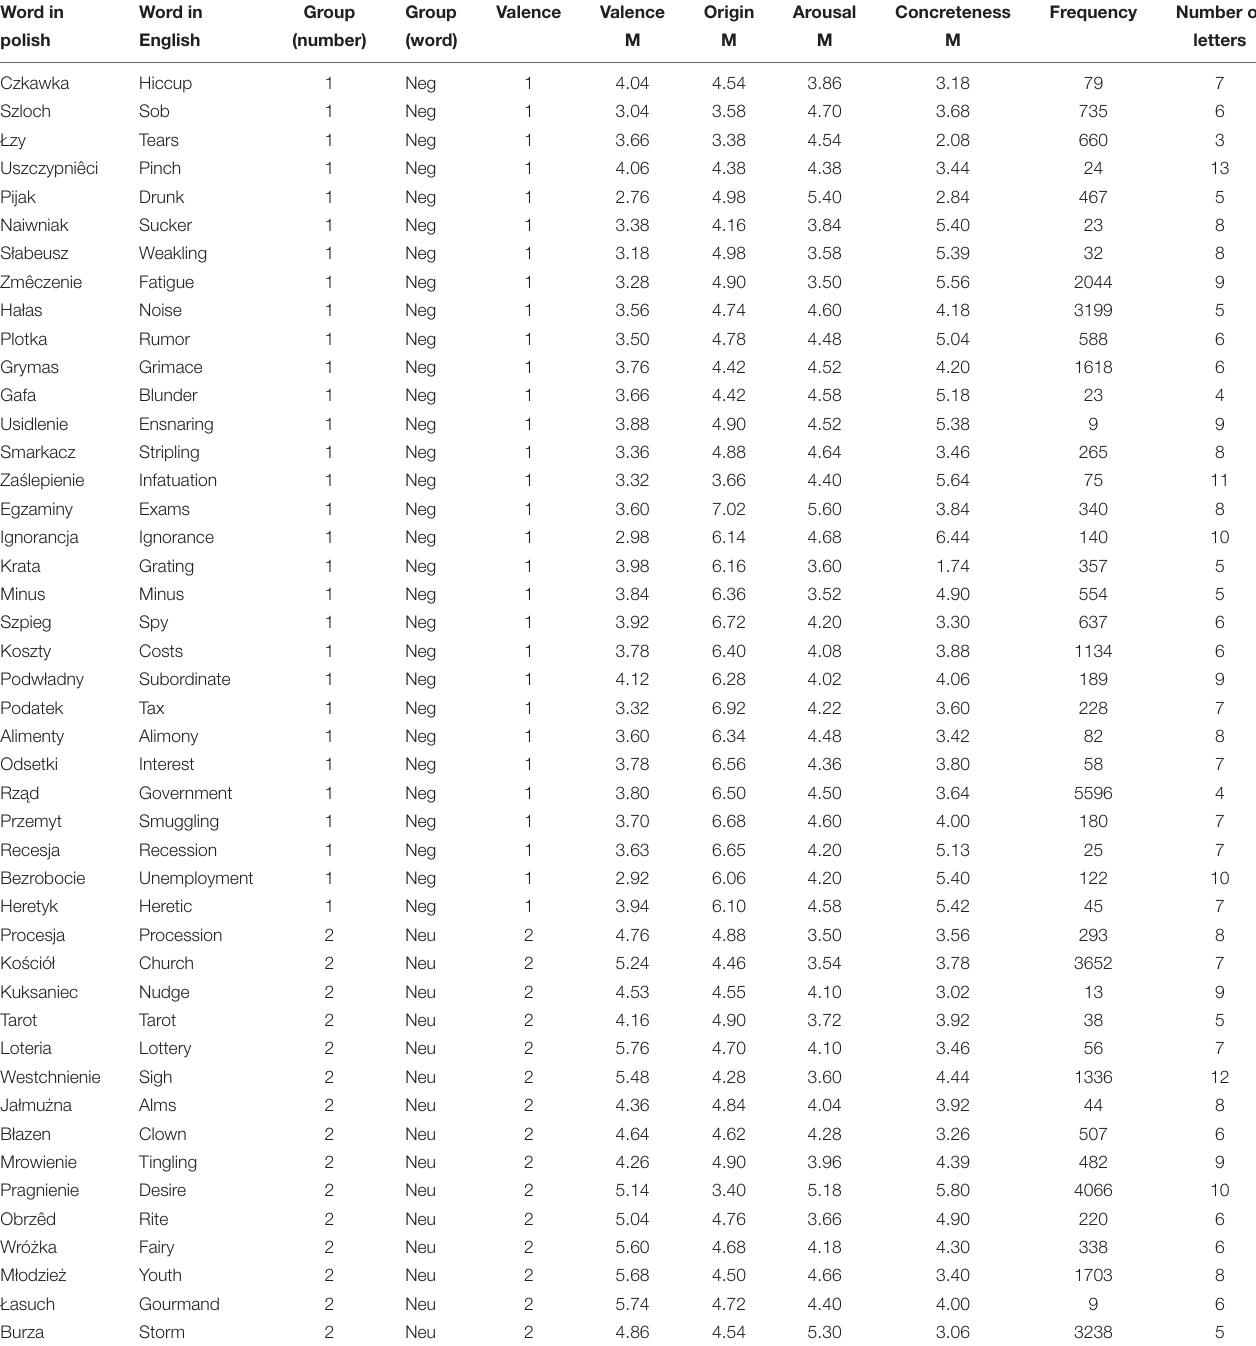
TABLE A1 | The list of stimuli used in the experiment with the accompanying affective norms taken from ANPW_R dataset (Imbir, 2016). Word in Word in Group Group Valence Valence Origin Arousal Concreteness Frequency Number of English (number)